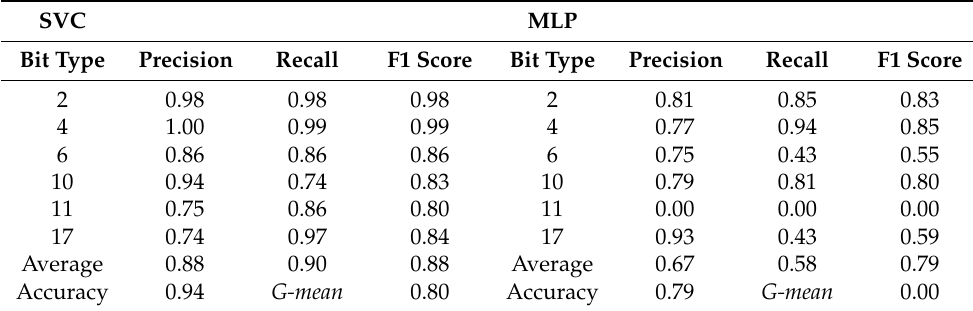
Table 12. The screening of 12.25” bits through SVC and MLP classifier. SVC MLP